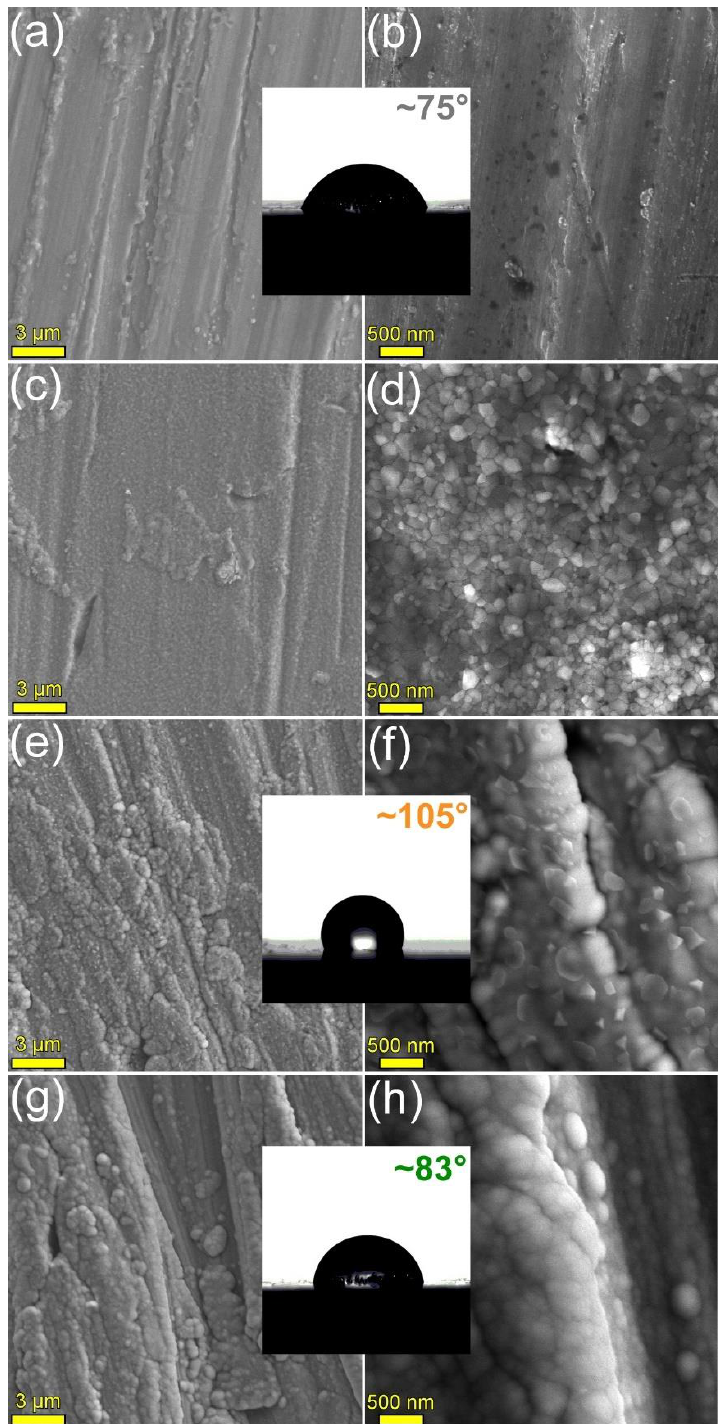
Figure 2. Characteristic FE-HRSEM images for the surface of the ( a , b ) bare as-fabricated, ( c , d ) bare 500 ◦ C annealed in air, ( e , f ) HA2 (post-deposition heat-treated at 500 ◦ C/1 h in air), and ( g , h ) BG2 (as-sputtered) RF-MS functionalized Mg-0.8Ca substrates. Insets: Typical CA images recorded for the surface of the bare and HA- and BG2-coated Mg-0.8Ca